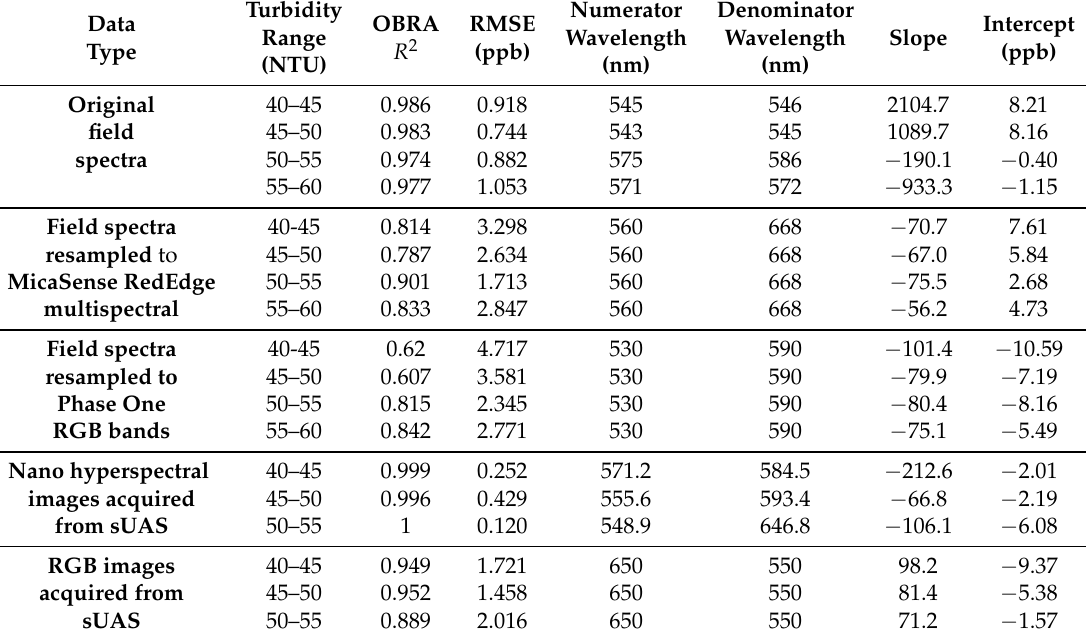
Table 2. Optimal band ratio analysis (OBRA) results for the original and resampled field spectra and hyperspectral and RGB images for each of the turbidity ranges observed during the experiment.